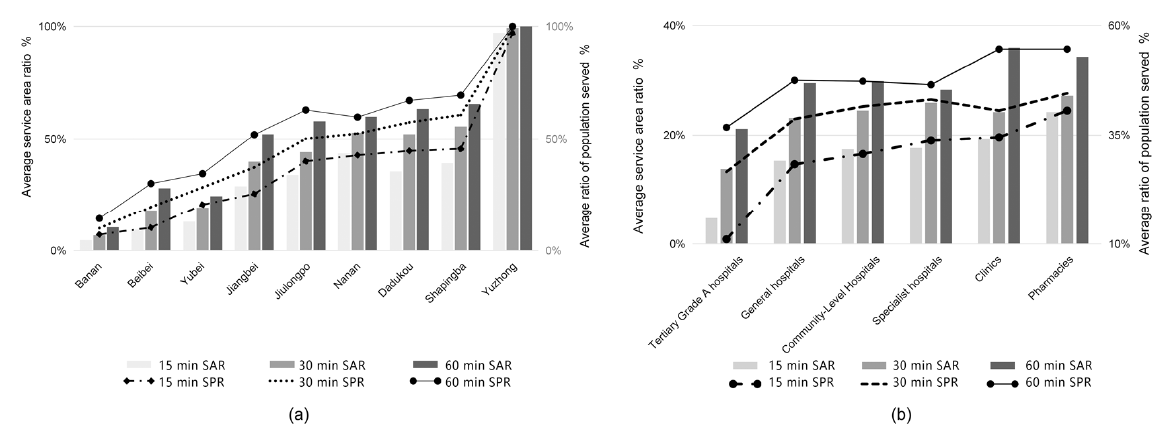
Figure 7. Accessibility of medical facilities: ( a ) average service area rate and average service popu- lation rate by the district; ( b ) the average service area rate and average service population rate of various types of medications.